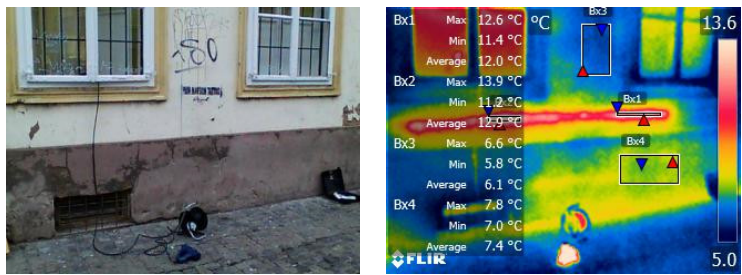
Figure 20. Homogeneous thermal pattern on excitation along the wall.